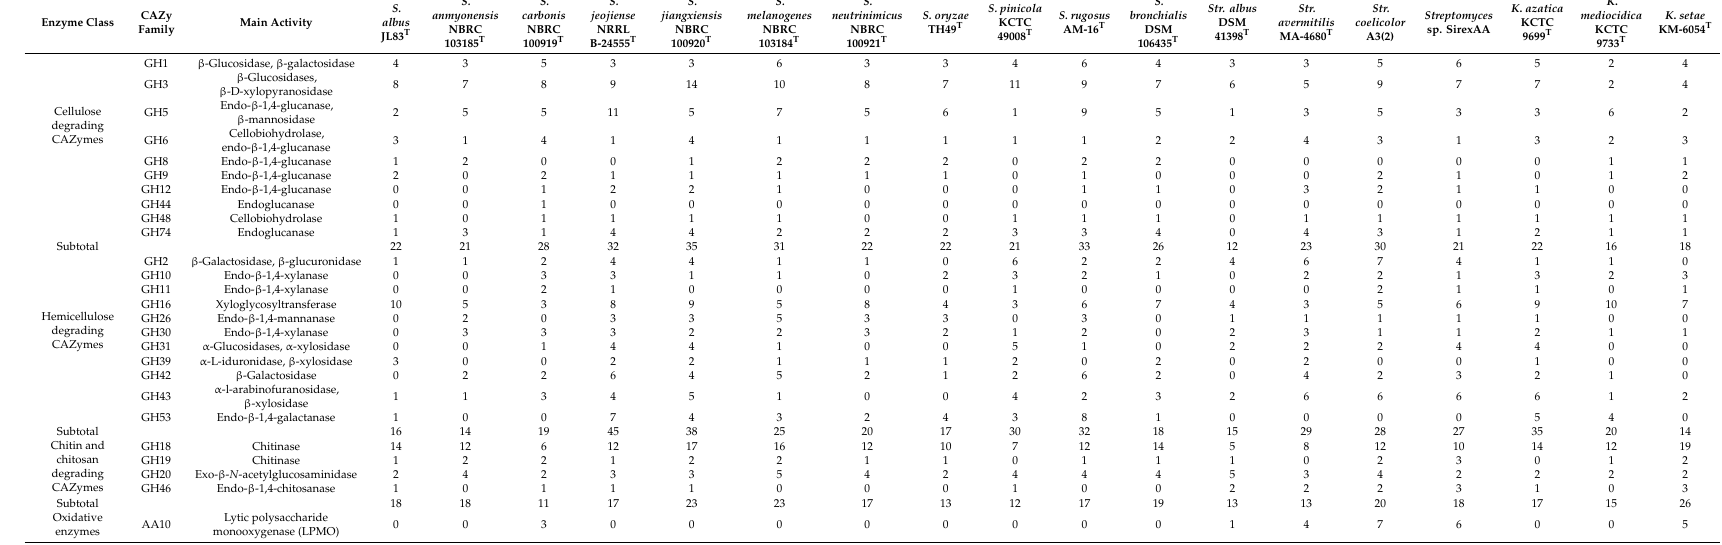
Table 5. Distribution of key CAZymes involved in the degradation of complex carbohydrates among Streptacidiphilus and their comparison with representative Streptomyces and